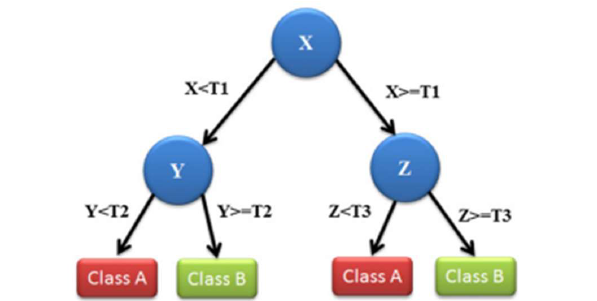
Figure 3. Example of Decision Tree